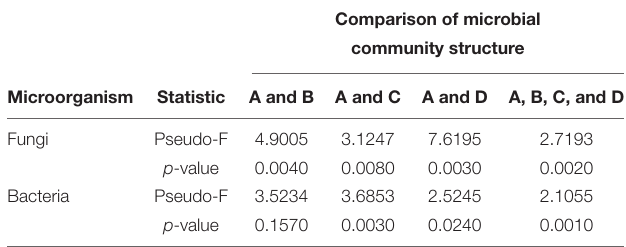
TABLE 2 | Permutational multivariate analysis of variance (PERMANOVA) of microbial community structure in soil 14 days after disinfectant treatment. Comparison of microbial community structure